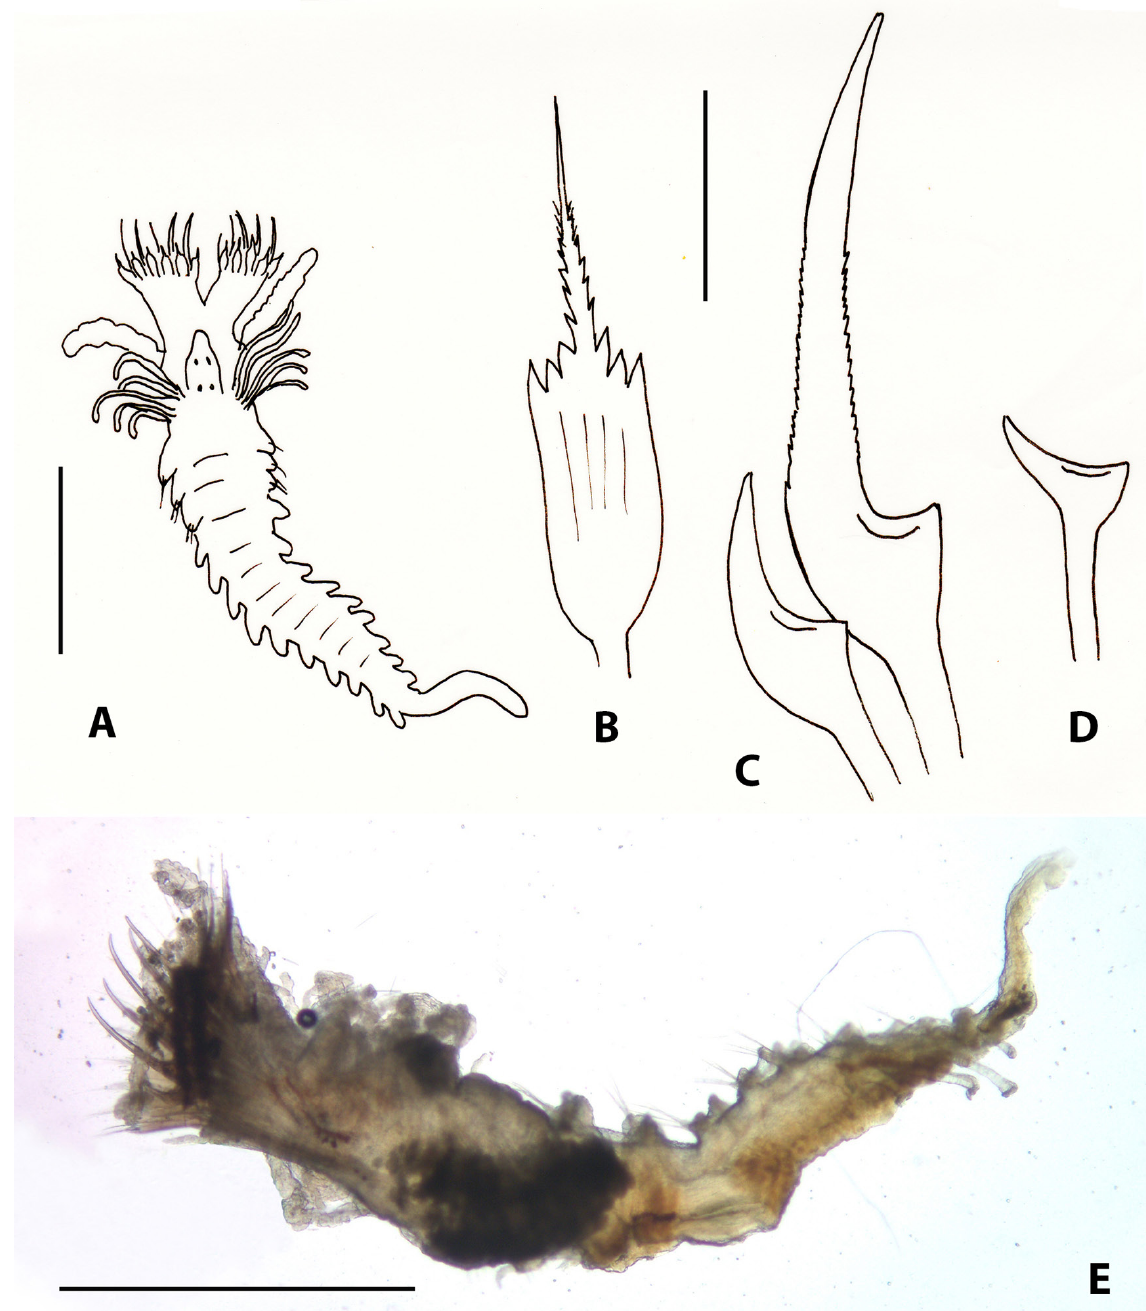
Fig. 10. – Sabellaria spinulos. A, juvenile 40 days after metamorphosis (74 days after fertilization) (scale bar 1 mm); B, outer paleae (scale bar 100 m m); C, middle paleae (scale bar 100 m m); D, inner palea (scale bar 100 m m); E, photo from 40 days after metamorphosis juvenile (74 days after fertilization) (scale bar 1